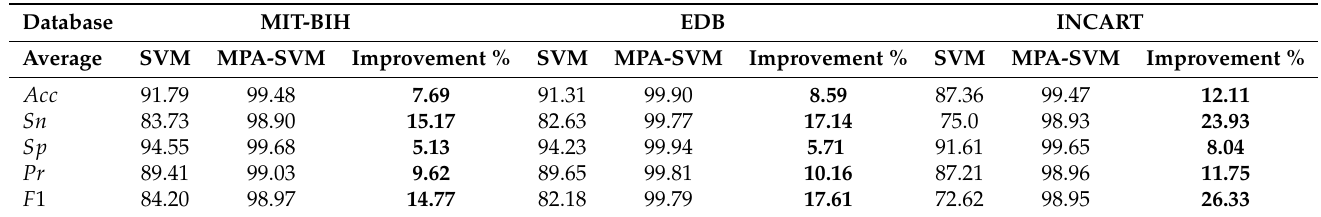
Table 8. The performance comparison of the SVM and its optimized version, the MPA-SVM.